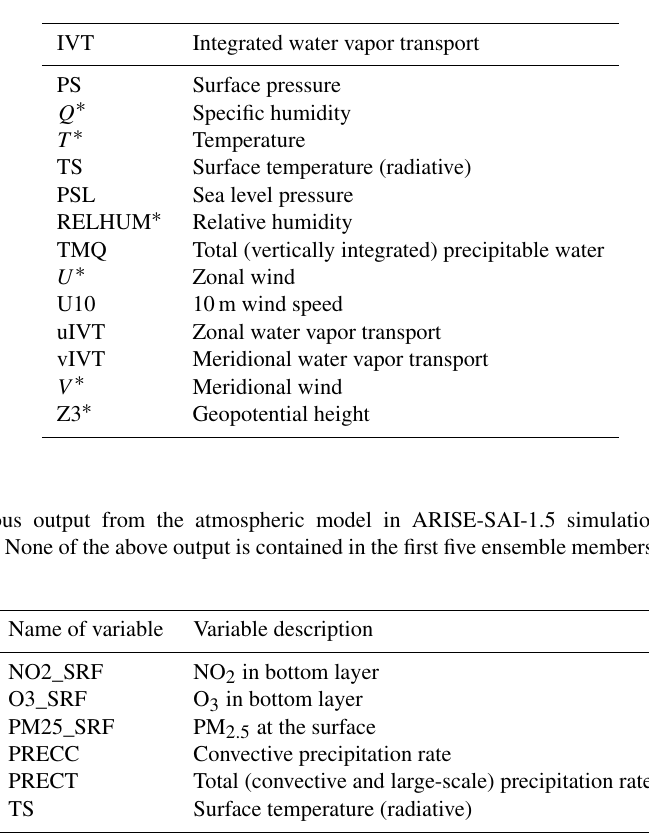
Table A4. 3-hourly instantaneous output from the atmospheric model in ARISE-SAI-1.5 simulations and five additional SSP2–4.5 CESM2(WACCM6) simulations. For the variables marked with an asterisk ( ∗ ), only the bottommost 22 levels were retained; hence, levels for those variables range from 1000 to 103hPa. None of the above output is contained in the first five ensemble members of CESM2(WACCM6) SSP2–4.5 simulations.